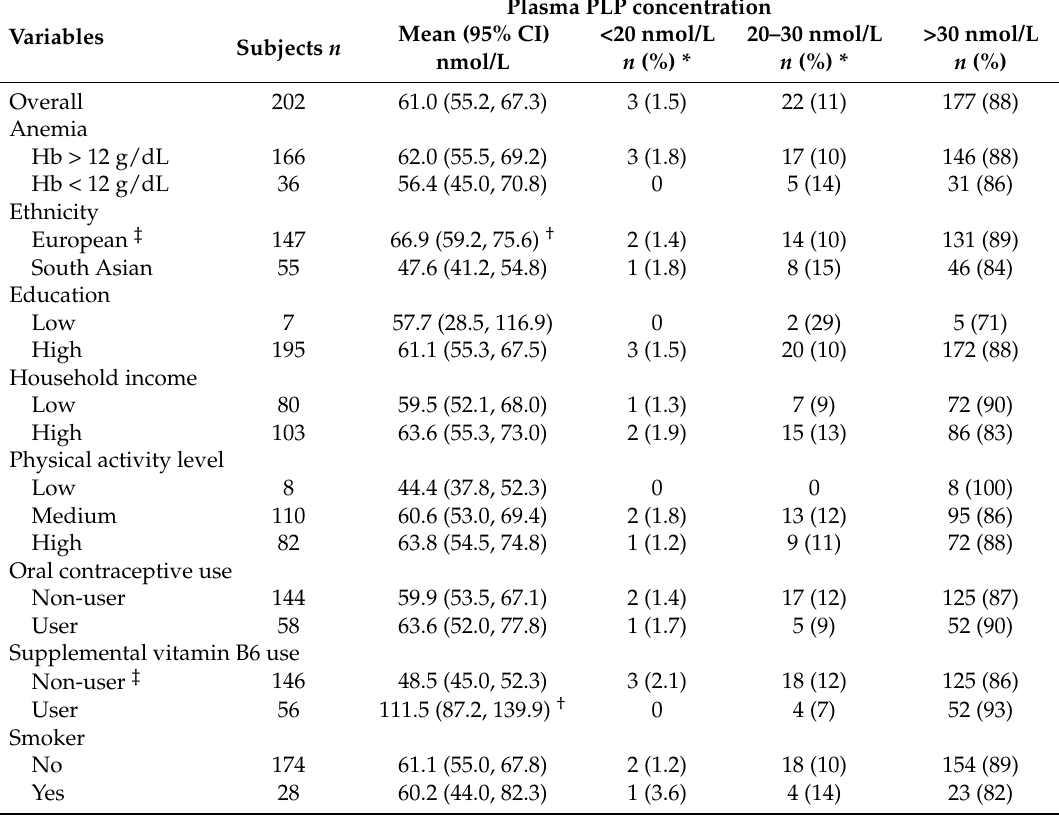
Table 2. Differences in plasma pyridoxal 5’-phosphate (PLP) concentration in 202 healthy young adult women by categories of demographic and lifestyle